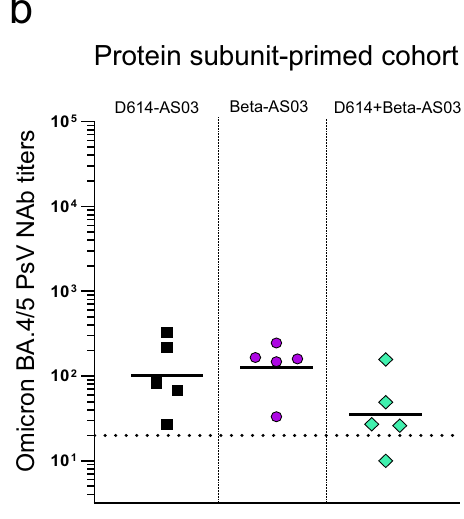
Fig.3|NeutralizingantibodyresponsesagainstSARS-CoV-2OmicronBA.4/5at 6 months post-booster in primed macaques. Pseudovirus-neutralizing anti- bodies against Omicron BA.4/5 variant were assessed at a day 176 (mRNA-primed macaques, n =4) or b day 178 (protein-primed macaques, n =5) post-booster with